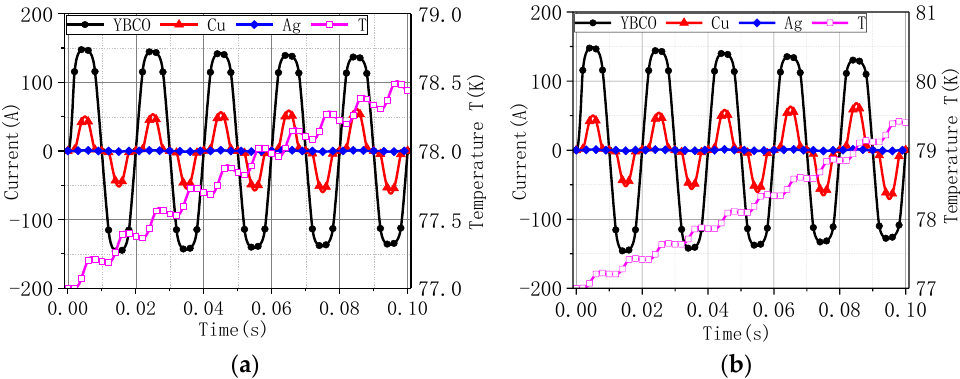
Figure 6. The current diversion and the highest temperature value under 200 A: ( a ) Model 1; ( b ) Model 2.